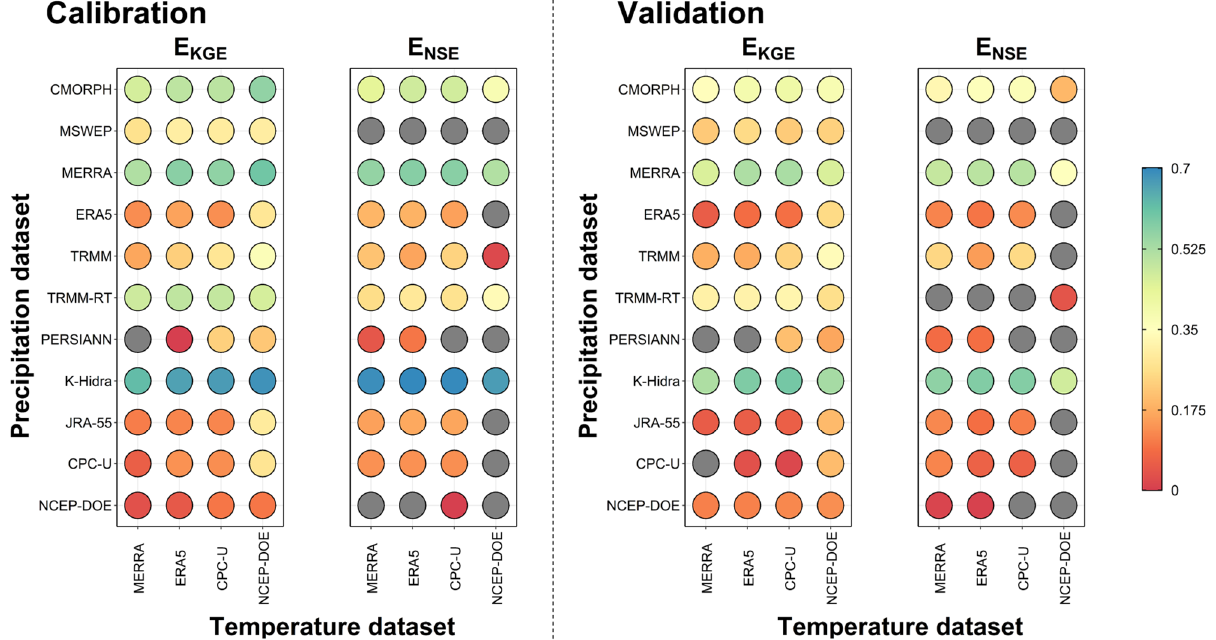
Figure 6. Average of the Kling-Gupta efficiency and Nash-Sutcliffe efficiency for the 26 daily stream- flow simulations during ( left ) the calibration period and ( right ) the validation period for forty-four combinations of 11 precipitation datasets ( y -axis) and 4 temperature datasets ( x -axis) employed as forcing in hydrological modeling. Gray color indicates averaging value is less than zero value for each metric.